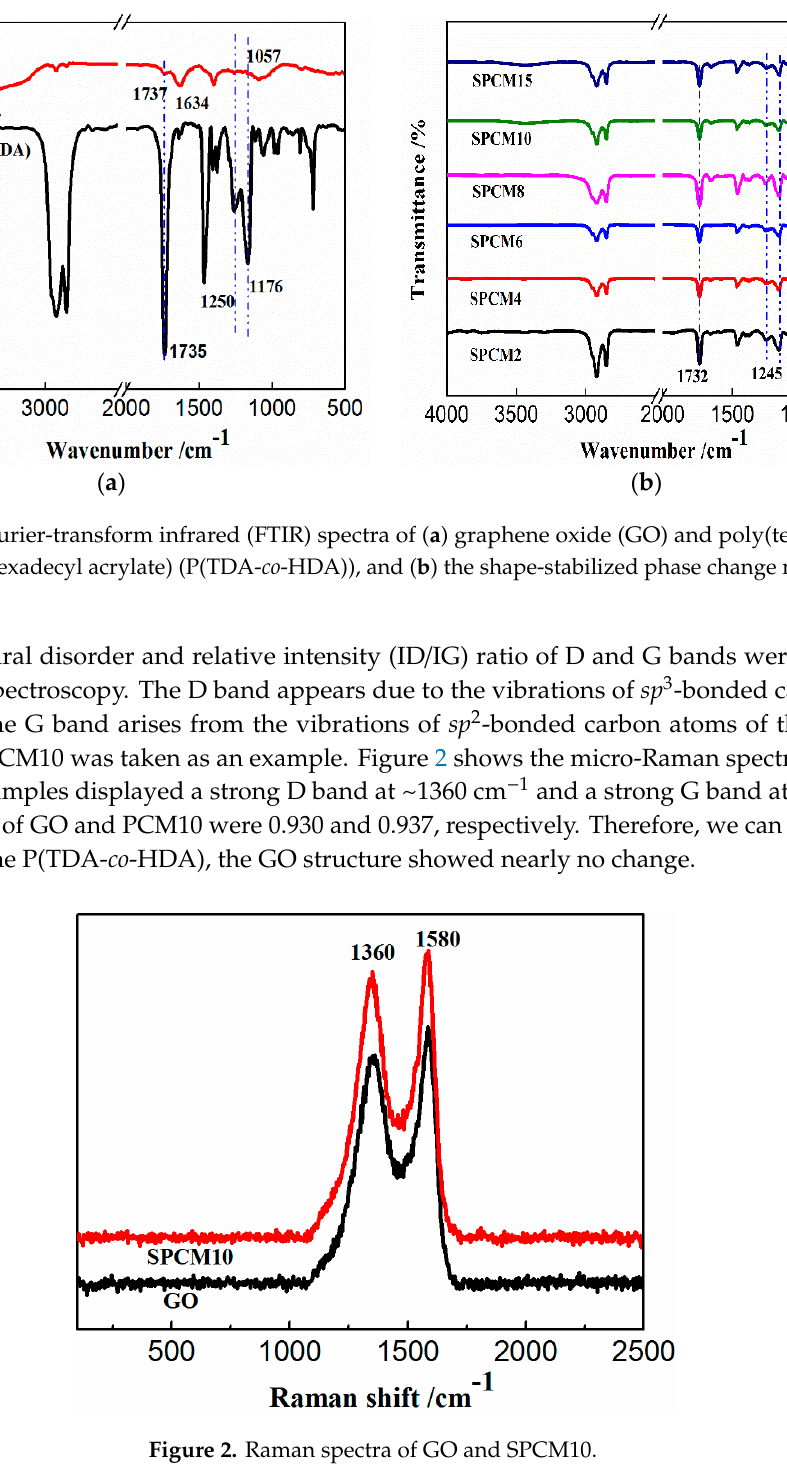
Figure 2. Raman spectra of GO and SPCM10.